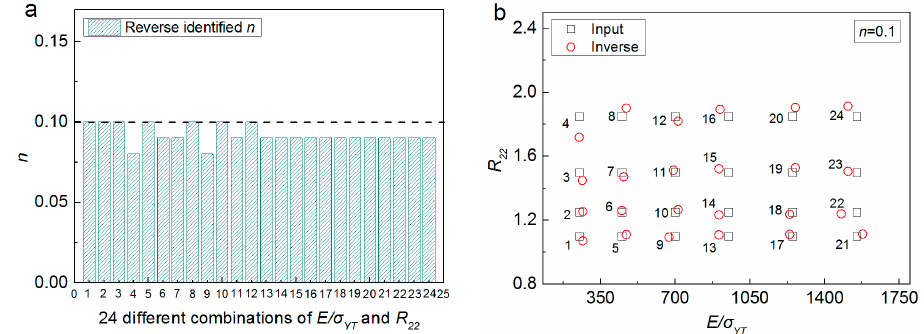
Figure 11. Comparison of 24 different combinations of FE “Input” anisotropic parameters with those identified by using the inverse algorithm: ( a ) R 22 ; ( b ) E / σ YT and n .